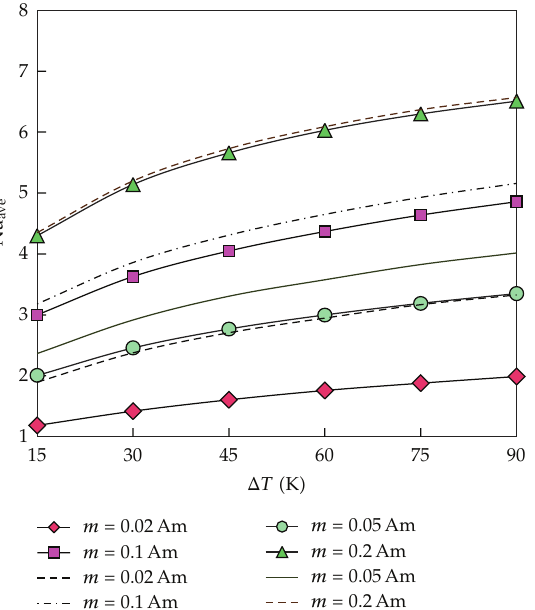
Figure 8: Average Nusslet number based on the magnetic force and combination of magnetic and buoyancy force. (cid:3) The solid lines are the Nu ave based on the combination of the magnetic and buoyancy force. The marked lines are calculated based on the magnetic force only.